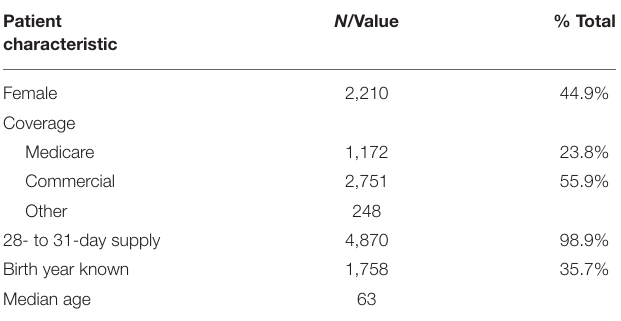
TABLE 1 | Patient demographics.